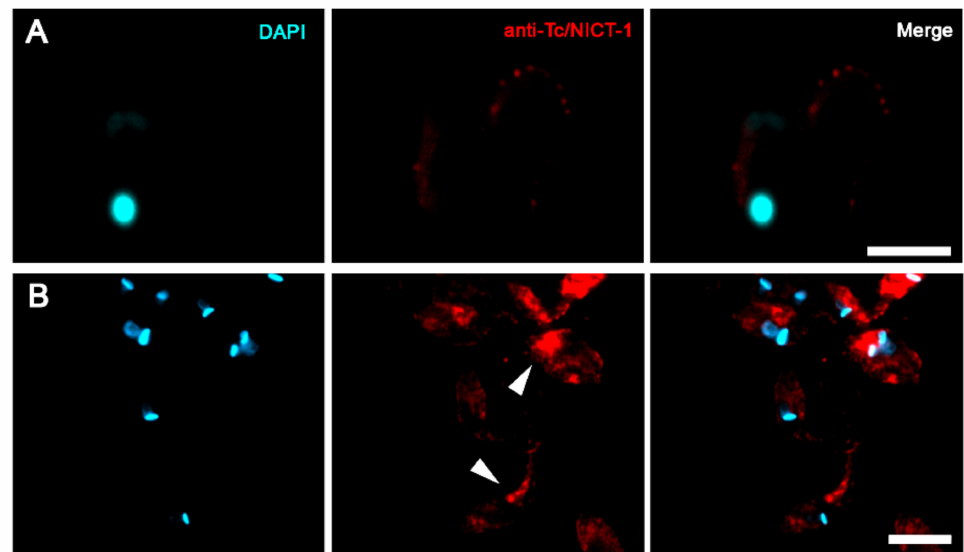
Figure 3. Immunofluorescent localization of T. cruzi nicastrin-like protein in trypomastigotes and epimastigotes. Cultures of trypomastigotes ( A ) and epimastigotes ( B ) were labeled with DAPI (cyan) and anti-Tc/NICT-1 (red). The merged images show the punctate membrane localization in trypomastigotes and a concentration of signal near the flagellar pocket (white arrowed) in individual epimastigotes or dividing cells. Scale bar = 10 µ